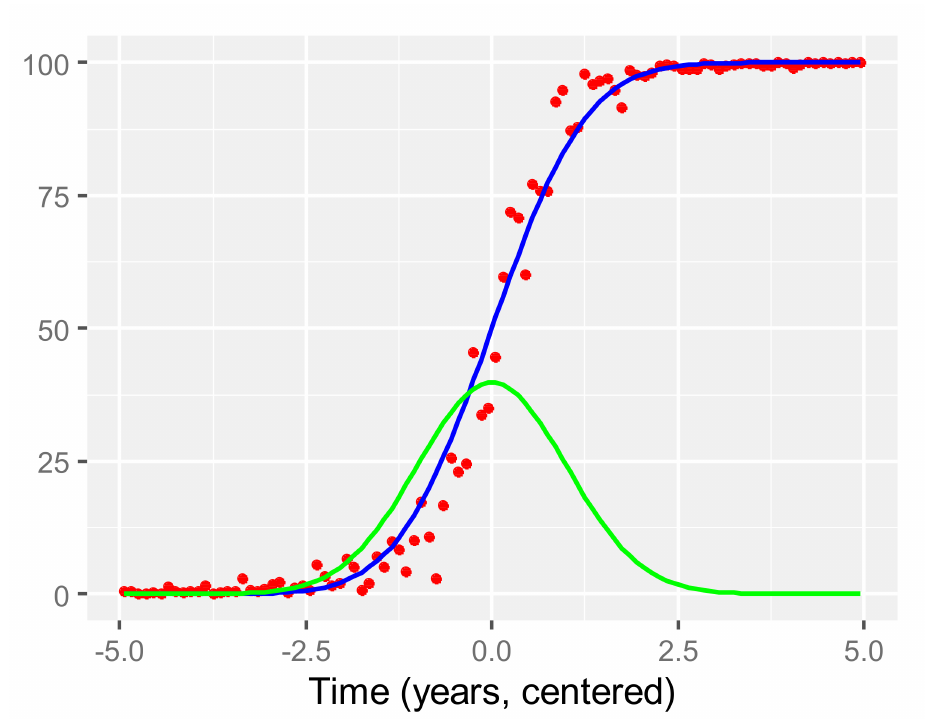
Figure A3. Mean observed and o ff set-corrected cumulative infestation (red dots), normal cumulative distribution function I ( t ) (CDF, in blue, scaled to 0–100), whose standard deviation is explained in text, and its derivative I (cid:48) ( t ) , i.e., the normal probability density function (in